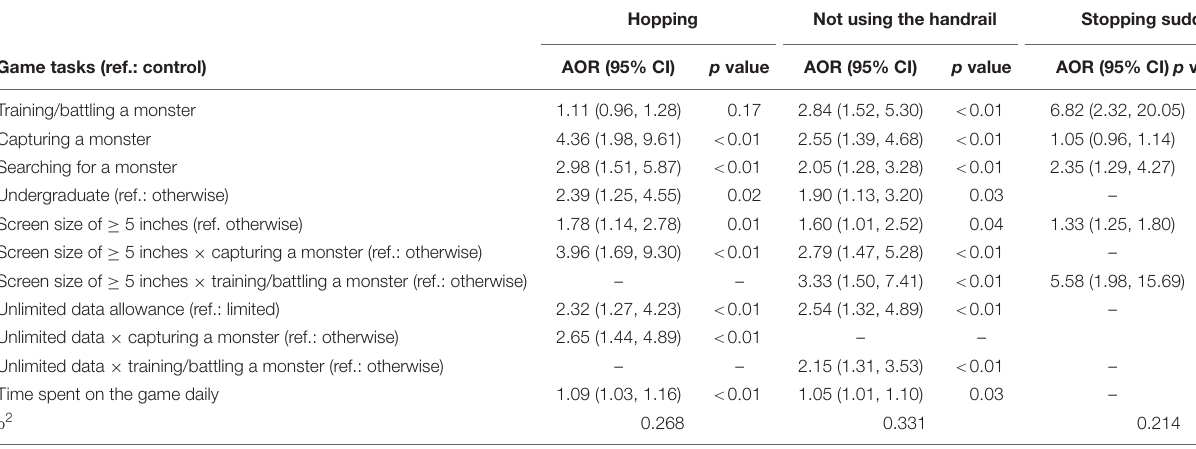
TABLE 4 | Odds of inattentional blindness and